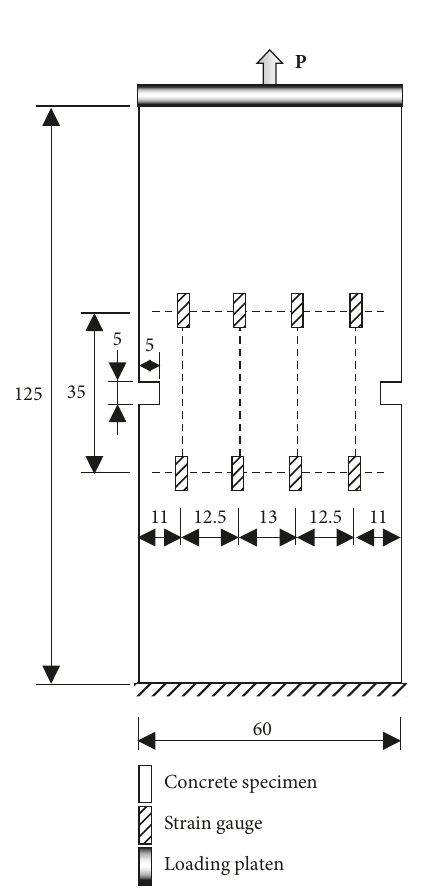
Figure 8: DEN concrete specimen: geometry, boundary, and loading conditions (dimensions in mm).